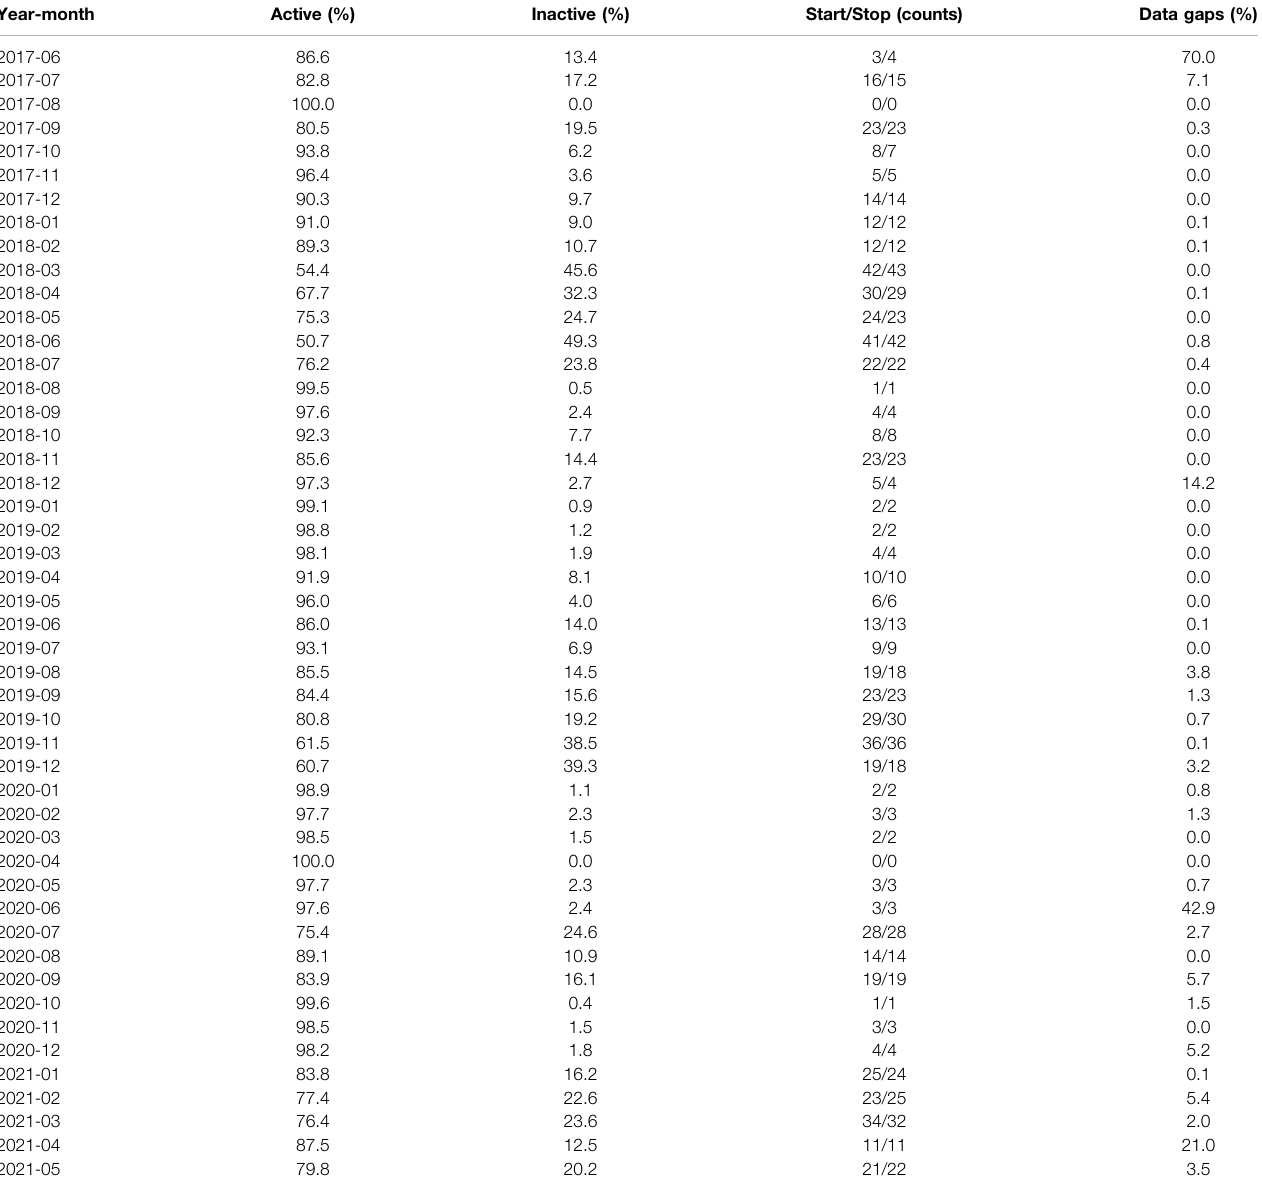
TABLE 1 | Percentages of activity and inactivity of gas emissions and numbers of gas emission activations (start) and cessations (stop) for each month from 22 June 2017 until 30 May 2021. The monthly percentages of missing hourly sonar scans (data gaps) are also given. The high percentages of data gaps in June 2017 and June 2020 are due to the fact that the monitoring period started on 22 June 2017 and that maintenance work was conducted on the sonar in June 2020. The activity/inactivity percentages ignore data gaps. Year-month Active (%) Inactive (%) Start/Stop (counts) Data gaps (%) 2017-06 86.6 13.4